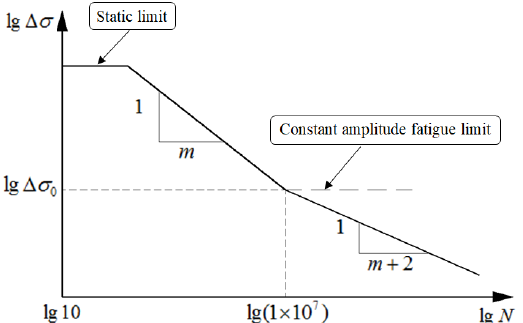
Figure 1. S-N curve of BSI standard.